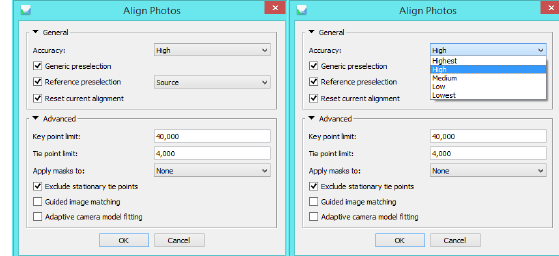
Figure 5 – Selection of the accuracy (number of points) that will be automatically detected as tie points for the alignment process (image matching and